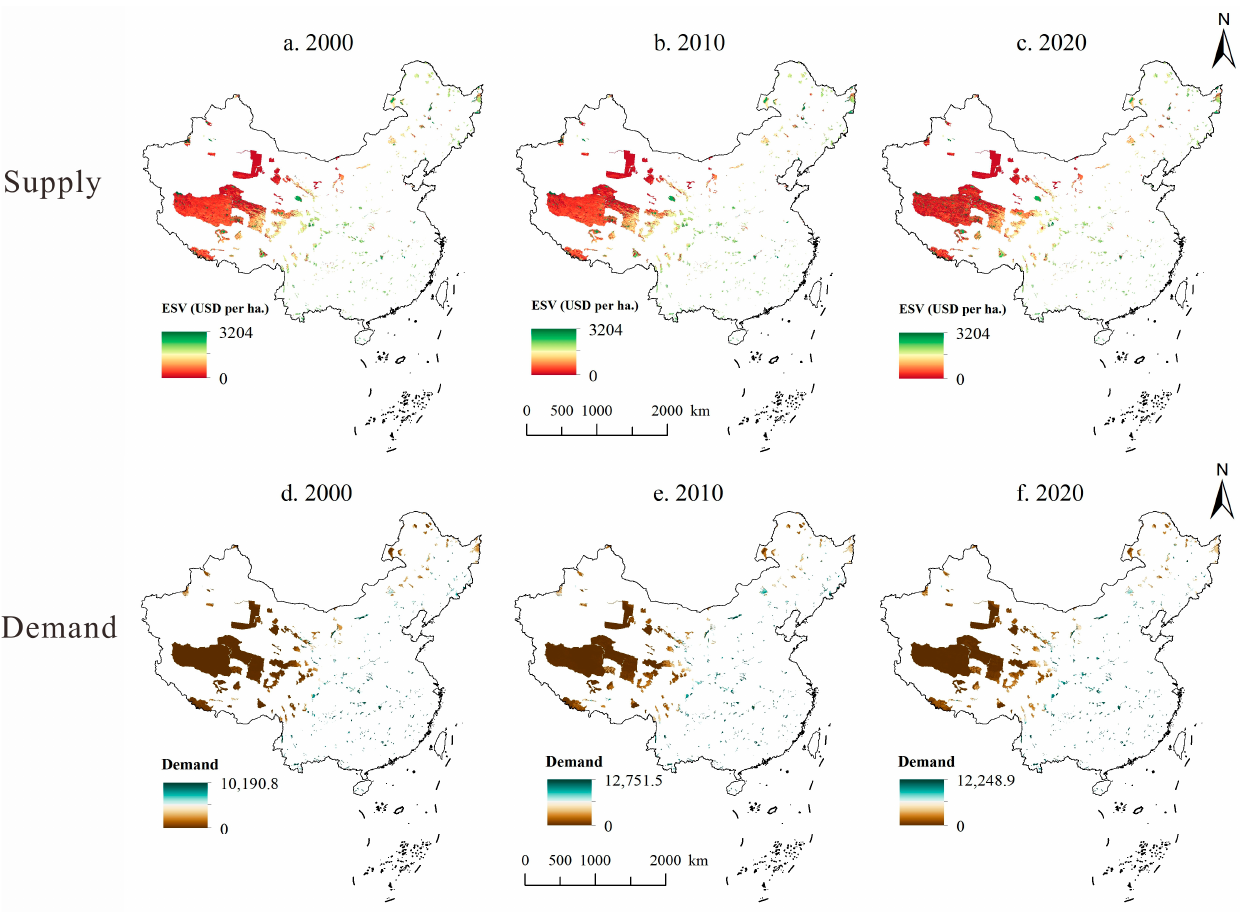
Figure 3. Ecosystem service supply and demand in National Nature Reserves from 2000 to 2020.